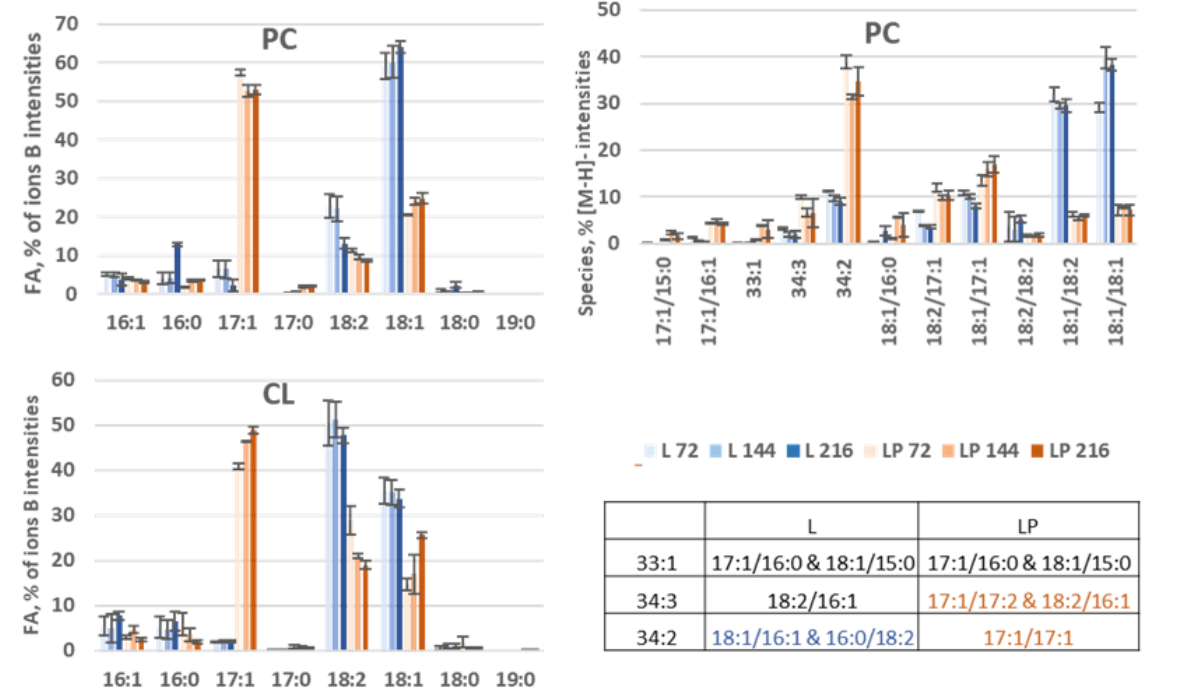
Figure 7. Comparison of the FA profiles in PL classes during OCFA production in the obese L and obese LP over time. On the left side, histograms represent the FA profiles expressed as % of total fatty acids. On the right side, histograms represent the % intensity of PLs molecular species (calculated from their [M-H] − ). Species noted 33:1, 34:3 and 34:2 correspond to isobaric species differing according to strains. The corresponding molecular species are indicated in the